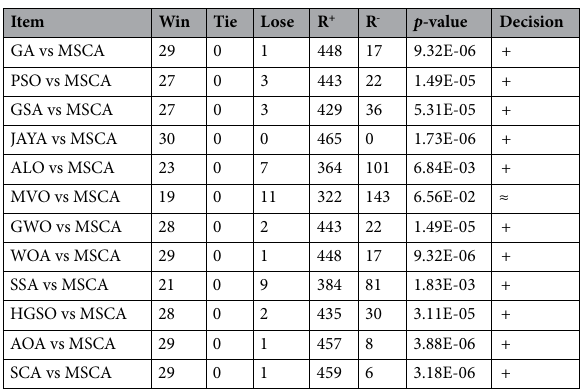
Table 9. Wilcoxon signed-rank test on CEC17 test suit at 5% level of